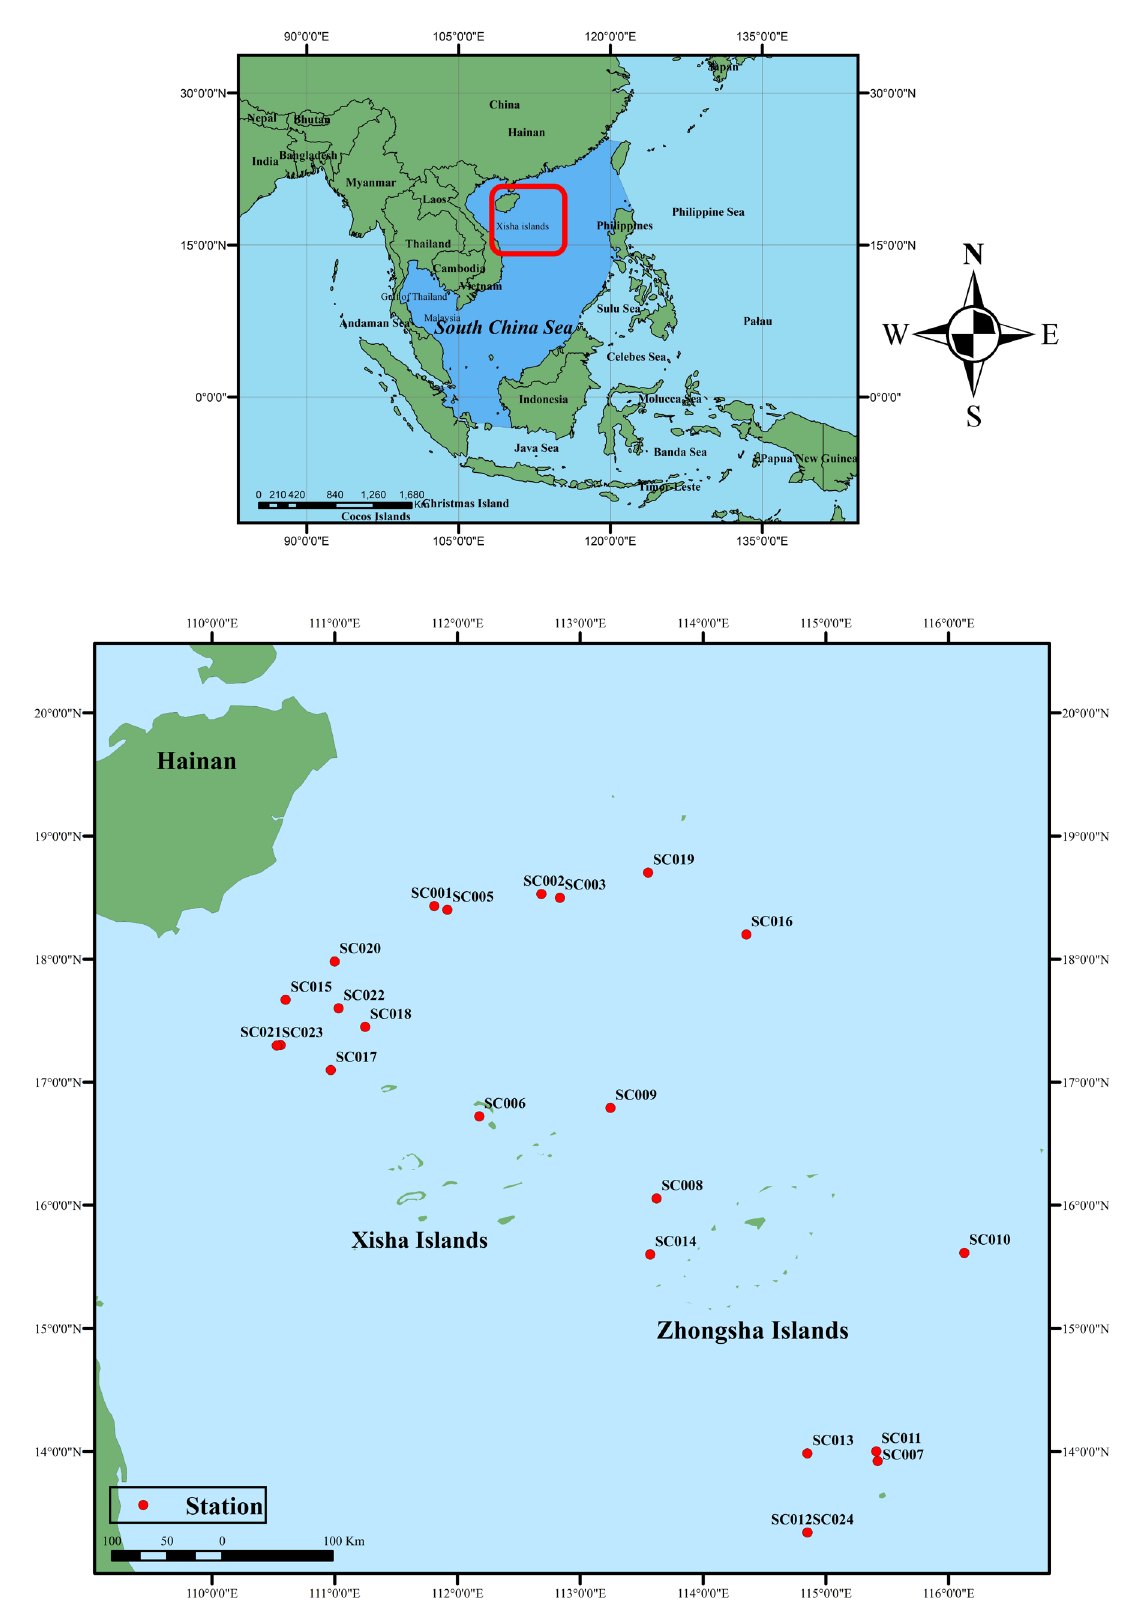
Fig. 1. Map of collecting stations in the South China Sea (Hainan, Xisha and Zhongsha Islands) in this study. Note: Gulf of Thailand included as part of the South China Sea. (Source: IHO & Sieger